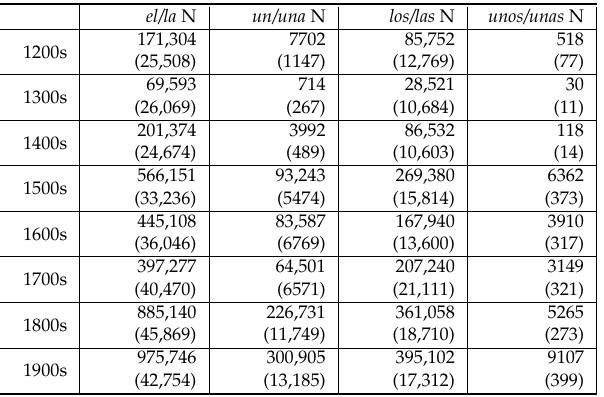
Table 1. Raw occurrences and frequency per million words of the definite and indefinite articles in the Corpus del español (Davies 2002–2019) 1 .